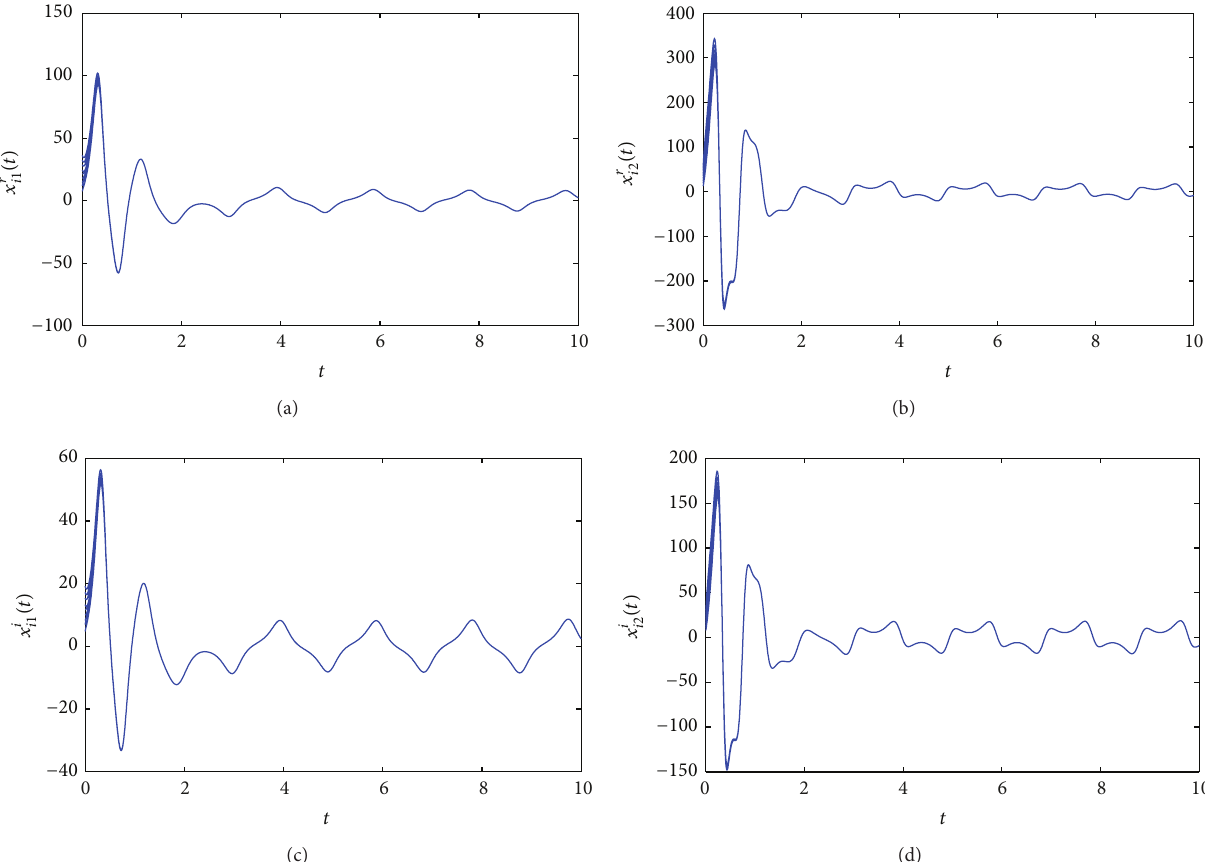
Figure 2: The evolution of the synchronization trajectory 𝑦 𝑖 (𝑖 = 1,2,...,10) by impulsive pinning